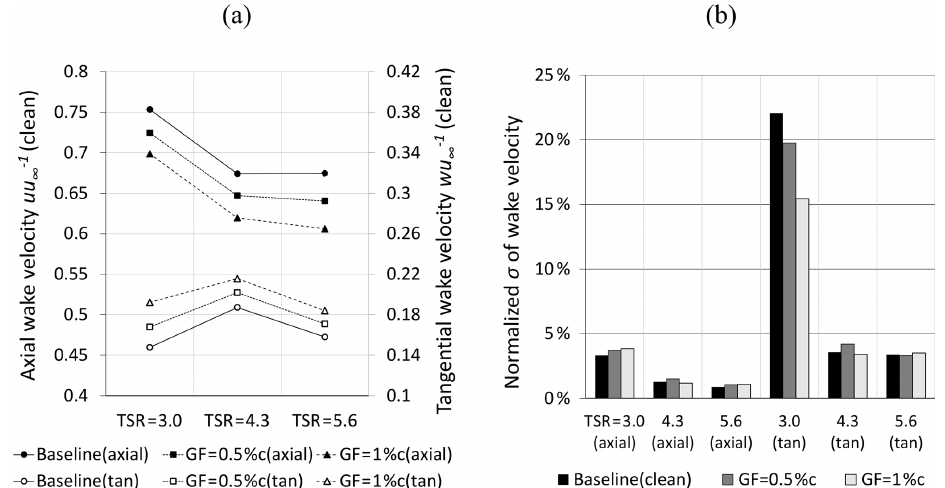
Figure A1. Clean case at r = 0.56 R and ϕ = 270 ◦ . (a) Axial and tangential (tan) wake velocity normalized by the inflow velocity. (b) Stan- dard deviation of the wake velocity normalized by the average wake velocity.